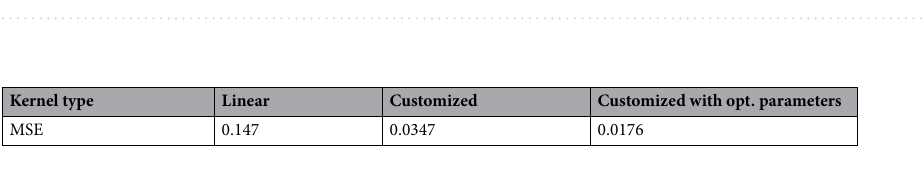
Table 1. Prediction errors in terms of mean squares in both interpolation and extrapolation settings in the high temperature viscosity prediction problem. Statistically significant results are highlighted in a bold font.